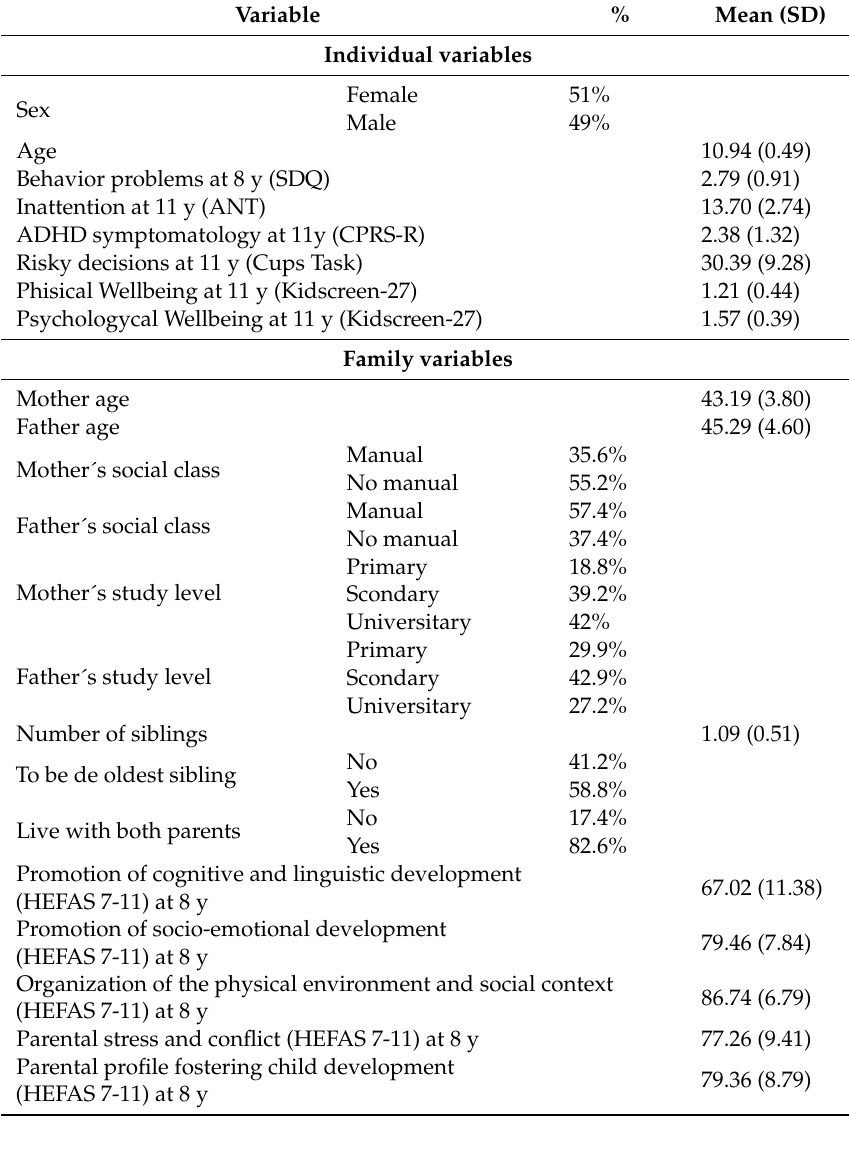
Table A1. Description of the